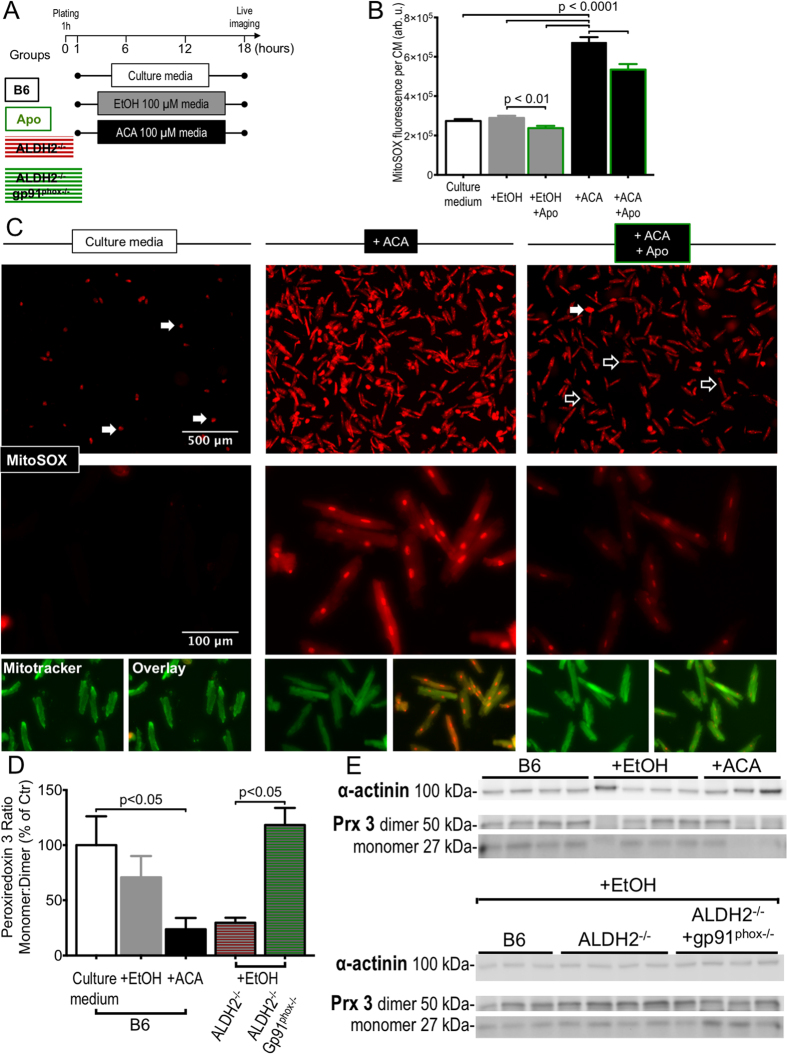
Pharmacologic inhibition or genetic ablation of NOX reduces mitochondrial superoxide production in isolated CMs cultured in the presence of EtOH and ACA.(A) Scheme depicting incubation and imaging of isolated adult CMs from B6, ALDH2−/− or ALDH2−/−/gp91phox−/− mice with apocynin (300 μM), EtOH (100 μM) or ACA (100 μM). (B) MitoSOX-enhanced fluorescence per CMs. Quantification of 205–931 CMs on 6–12 independent low power fields per group. (C) Representative fluorescence images of CMs loaded with MitoSOX after culture for 18h in control media (leftmost column) in the presence of ACA 100 μM (middle column) and in the presence of ACA (100 μM) together with the NOX inhibitor apocynin (300 μM) rightmost column. (D) Peroxiredoxin 3 ratio monomer/dimer determined by Western blot under non-reducing, denaturing conditions in n = 4–7 independent samples per group. (E) Representative original Western blots.